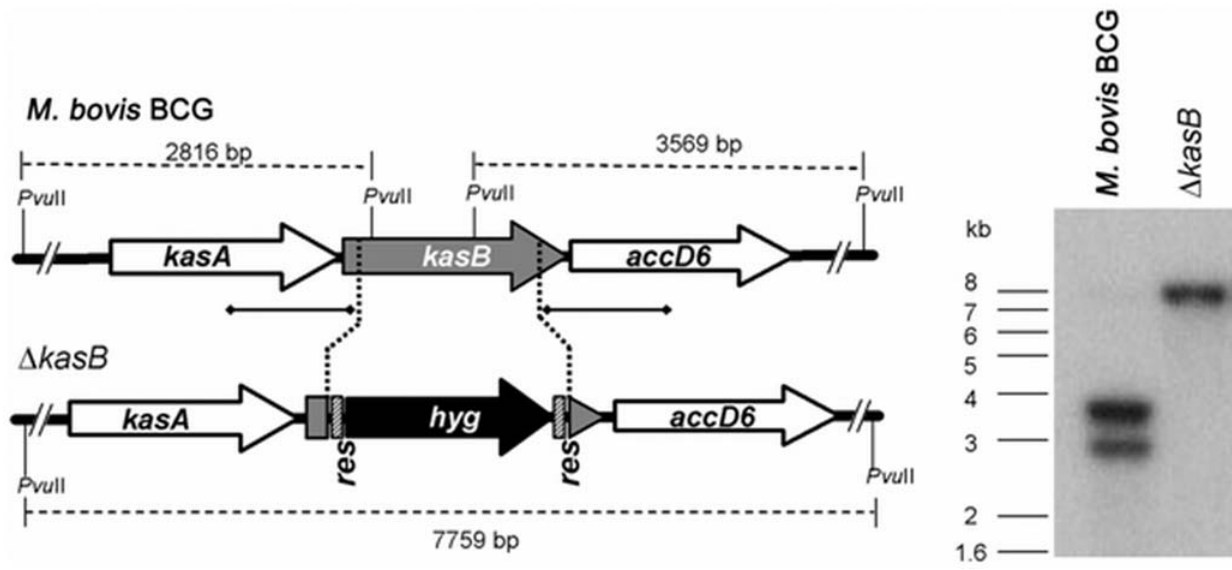
Figure 4. Generation of a M.bovis BCG kasB null mutant. Maps of the kasB region in the M. bovis BCG genome and its corresponding region in the conditional mutant D kasB are shown on the left, with the corresponding Southern blot on the right. The regions used as porbes are indicated by solid lines with square ends while the expected bands are indicated by broken lines (with sizes indicated). hyg , hygromycin resistance gene from Streptomyces hygroscopicus ; res , cd resolvase recognition sites.